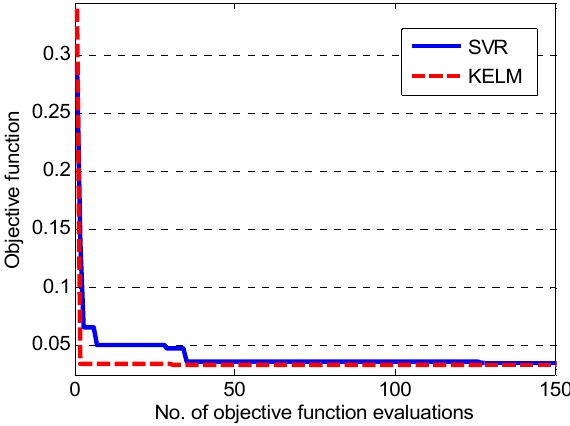
Figure 7. Convergence of the MVMO in the process of identifying optimal parameters of the AI.